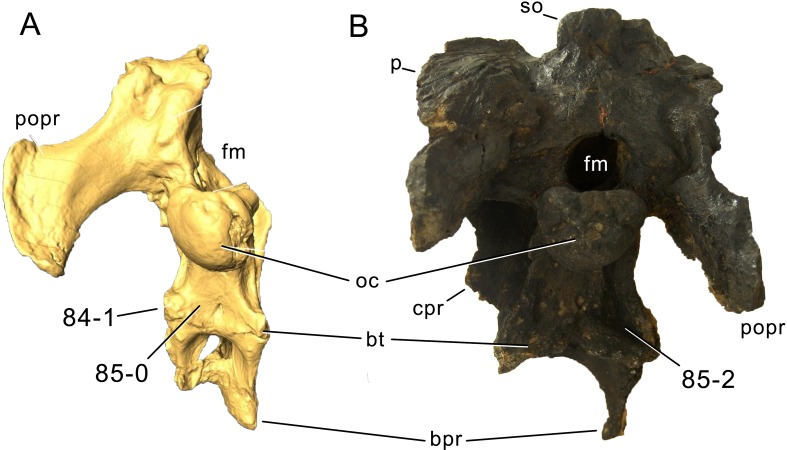
Diplodocimorph skulls in occipital view.Skulls of Nigersaurus taqueti (A; modified from Schmitt, 2012) and Galeamopus sp. USNM 2673 (B) in occipital view. Note the reduced basal tubera in Nigersaurus (A; C84-1), and the convex (A; C 85-0), or concave (B; C85-2) posterior face of the tubera. Abb.: bpr, basipterygoid process; bt, basal tuber; cpr, crista prootica; fm, foramen magnum; oc, occipital condyle; popr, paroccipital process; so, supraoccipital. Skulls scaled to same occipital condyle height.